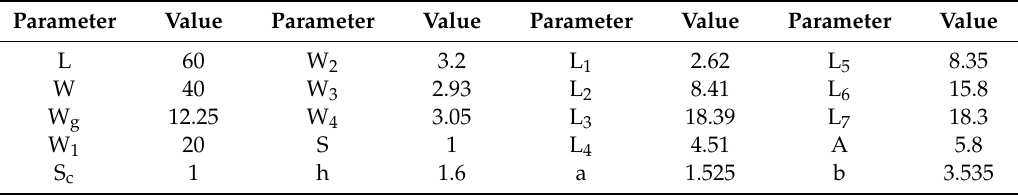
Figure 1. Geometrical dimensions of the proposed antenna. Table 1. Dimensions of the proposed antenna (all values are in mm).